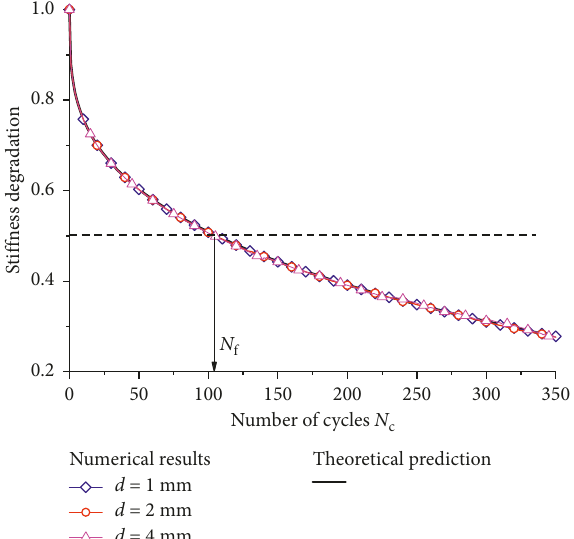
Figure 8: The theoretical and numerical predictions of the decrease of global stiffness for an uncracked plate subjected to fatigue loading.